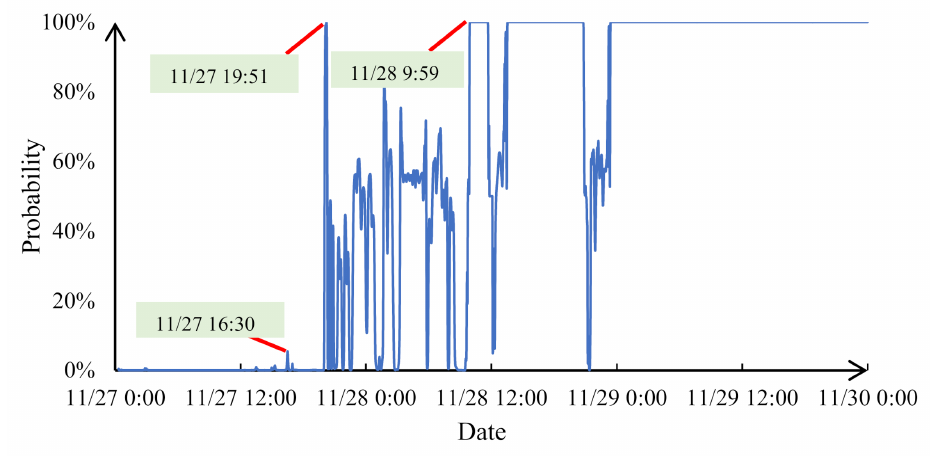
Figure 14. Failure probability